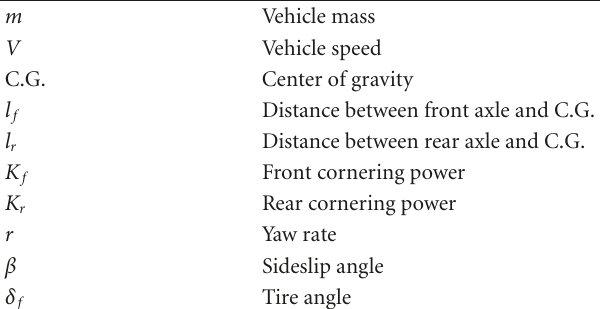
Figure 8: Two-wheel model of a vehicle. Table 2: Vehicle system parameters. Figure 9: Position of preceding vehicle during cornering, with consideration for the sideslip angle.